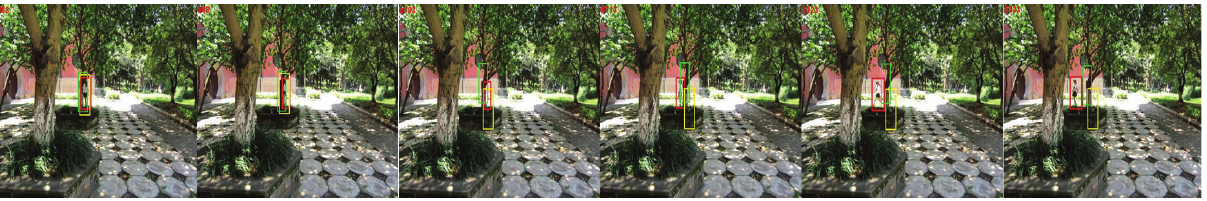
Figure 7: Tracking results of girl occlusion . Frames 83, 93, 103, 113, 123, and 133 are displayed.